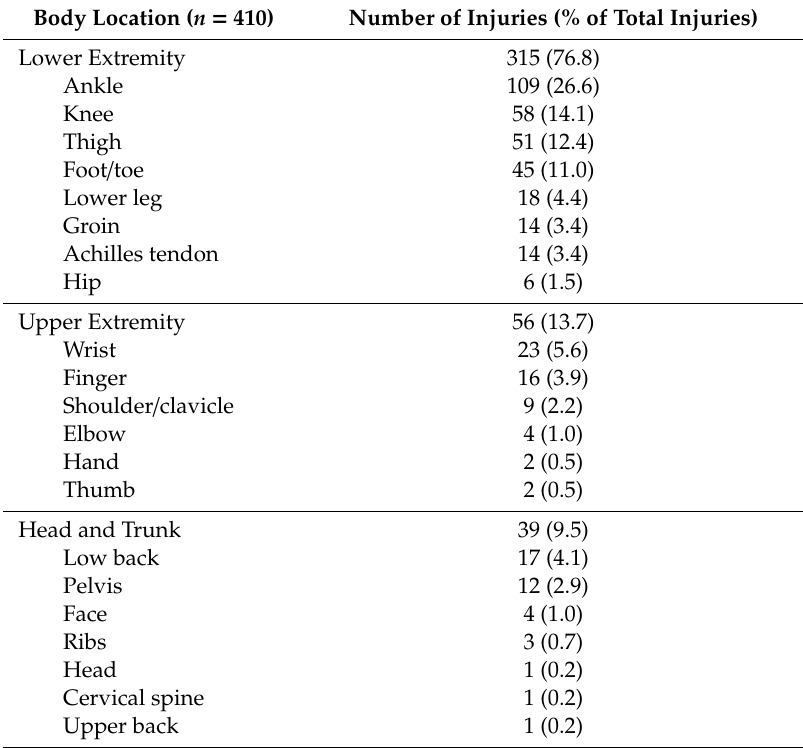
Table 4. Location of injuries in U-15 youth soccer during the 2019